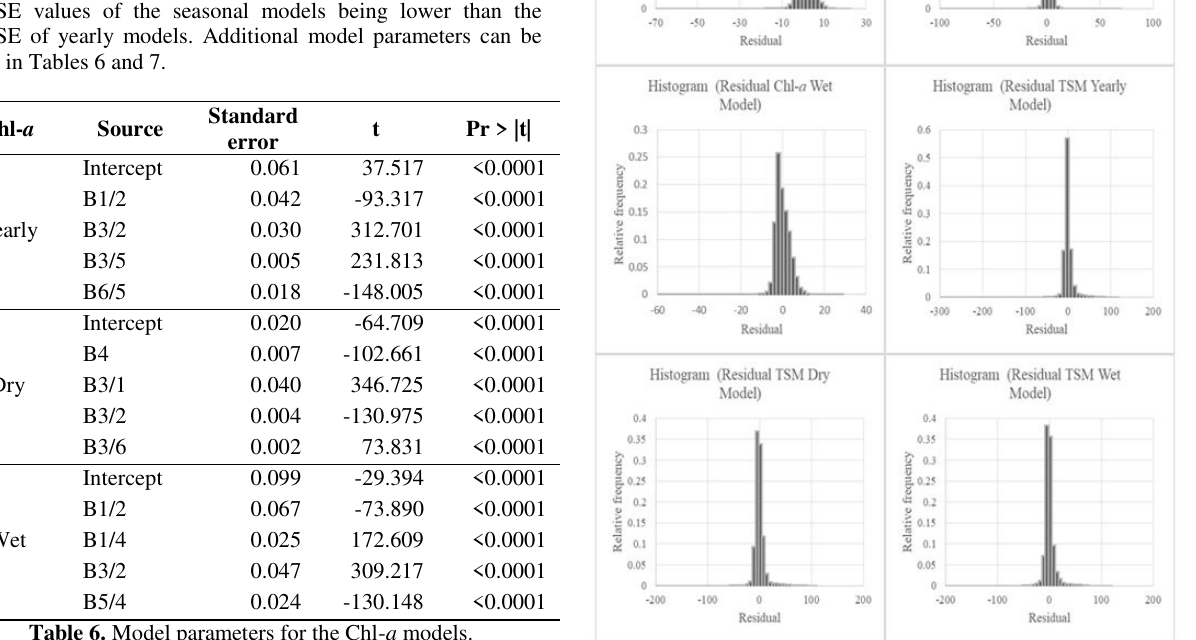
Figure 5. Histogram of residual of the models